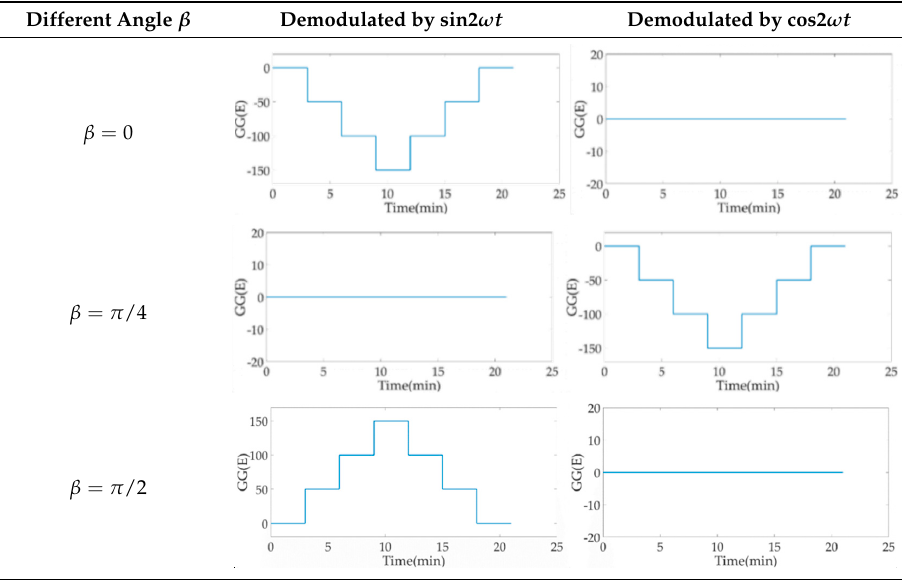
Table 1. Simulation results of RAGG with different angle 𝛽.